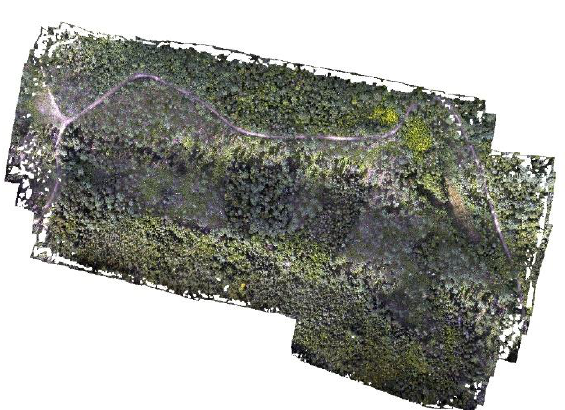
Figure 6. Orthomosaic produced from RGB images in 2018 (630m X